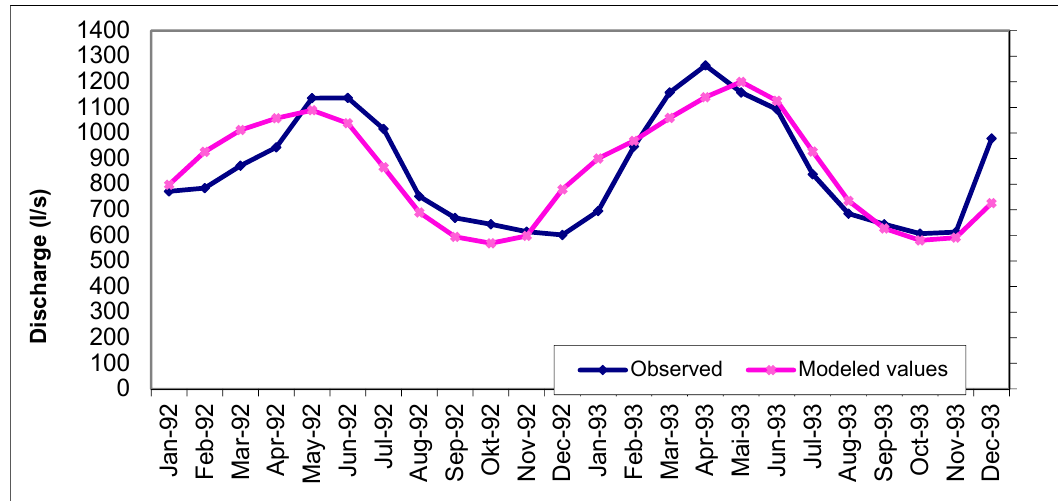
Figure 10. Comparison of observed and modeled discharge of Kefalovriso spring produced by SARIMA model (4,1,1) (1,1,1) 12 for the period 1992–1993. Table 5. Statistical properties of the observed and forecasted values of discharge at Kefalovriso spring using SARIMA model (4,1,1) (1,1,1) 12 for the two-year period 1992–1993. Modelling Efficiency Forecasted 858.40